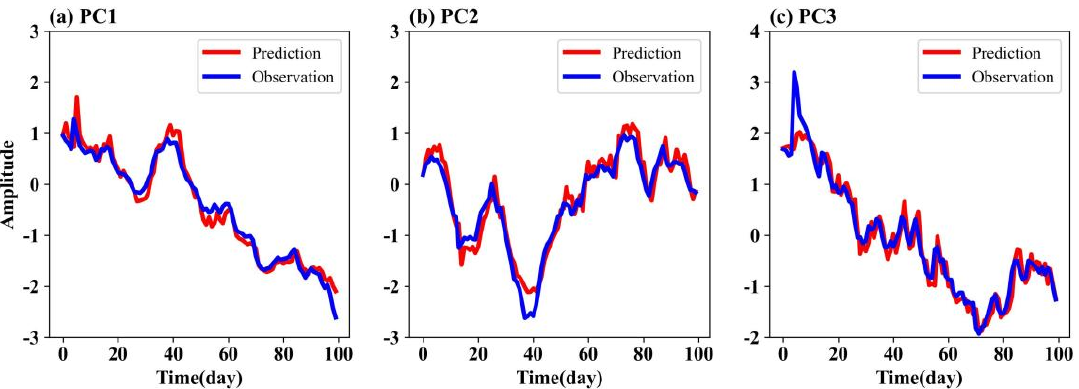
Figure 6. A snapshot of one of the 100 days (1 March to 9 May 2019) forecasting cycles produced by the ELD model (red line) and the truth principal component (PC1( a )–PC3( c )) (blue